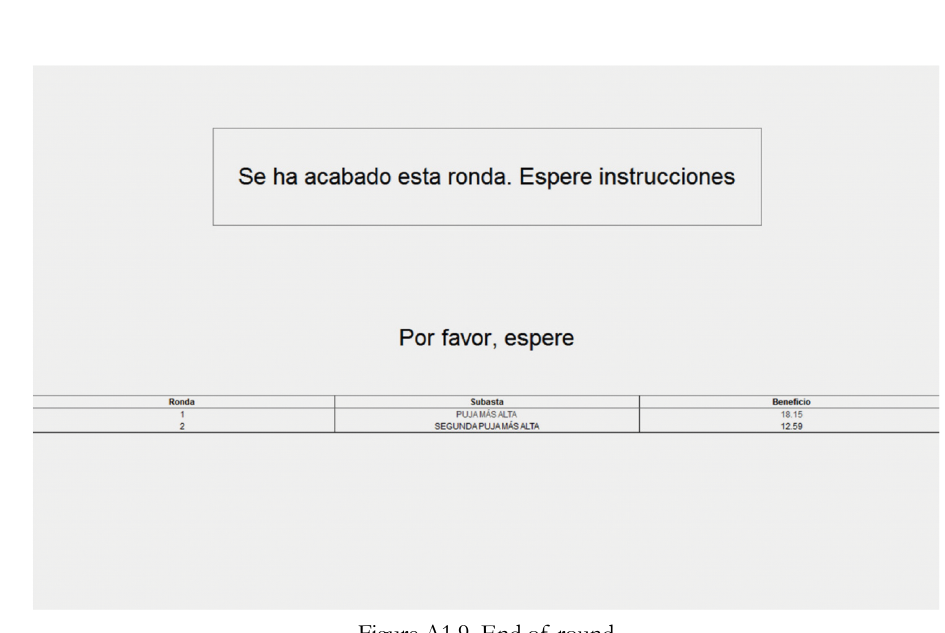
Figure A1.9. End of